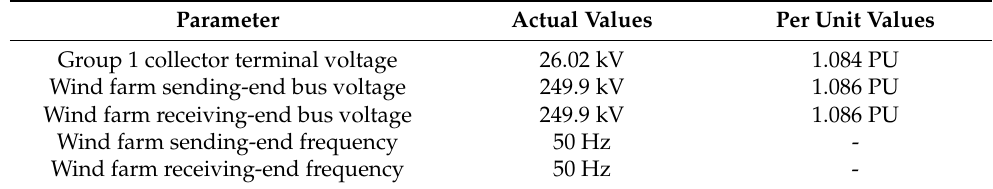
Table 7. Wind power plant sending-end monitored values at the steady-state power